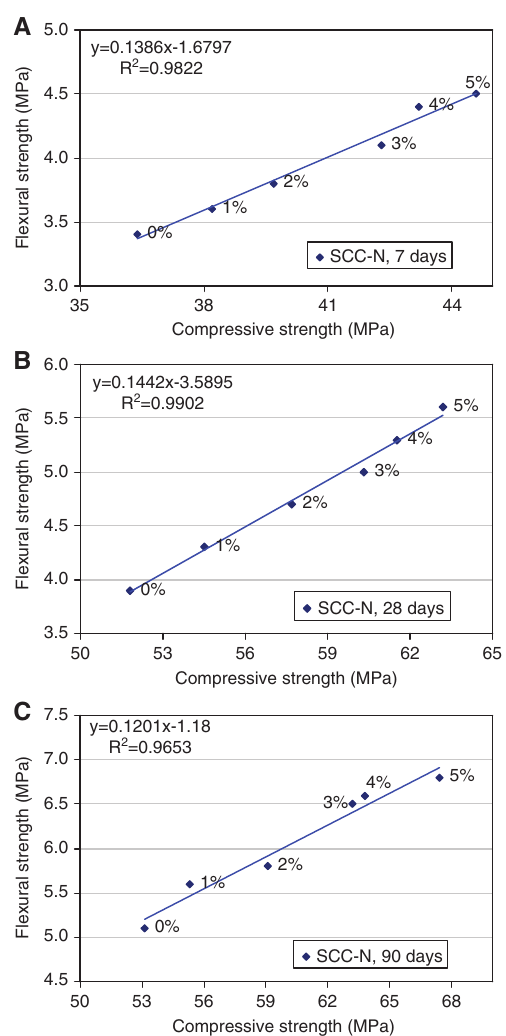
Figure 4 Relationship between flexural and compressive strength of SCC-N mixtures for (A) 7 days, (B) 28 days, and (C) 90 days of curing.